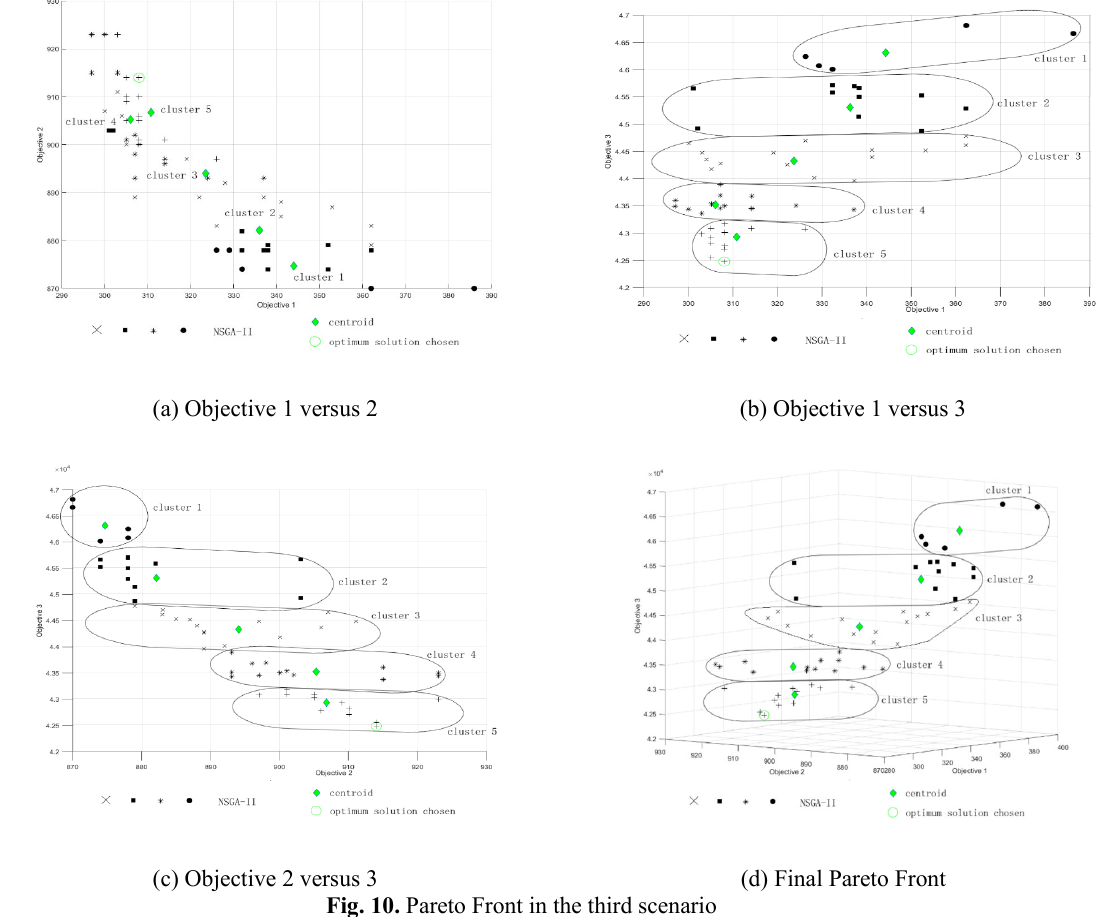
Fig. 10. Pareto Front in the third scenario